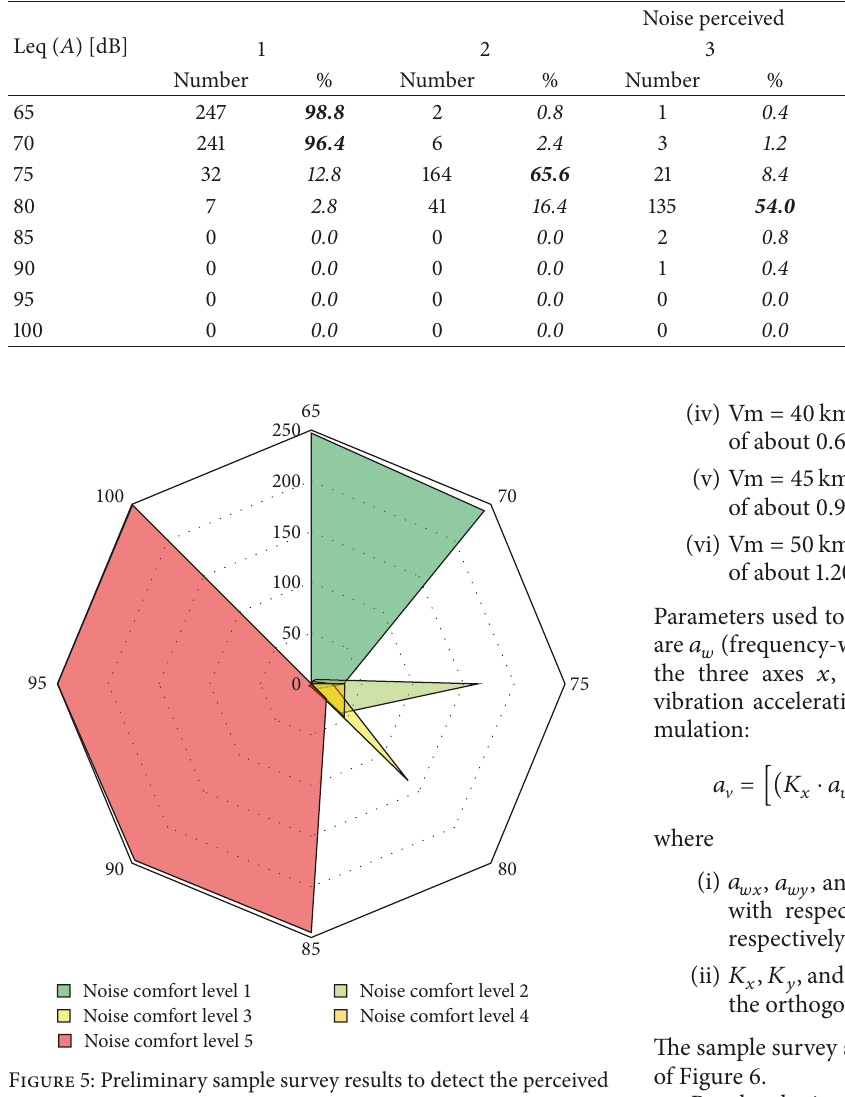
Table 1: Preliminary sample survey results to detect the perceived noise level.